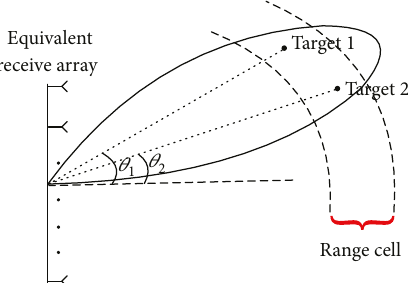
Figure 1: Sketch map of multitarget detection for early warning radar